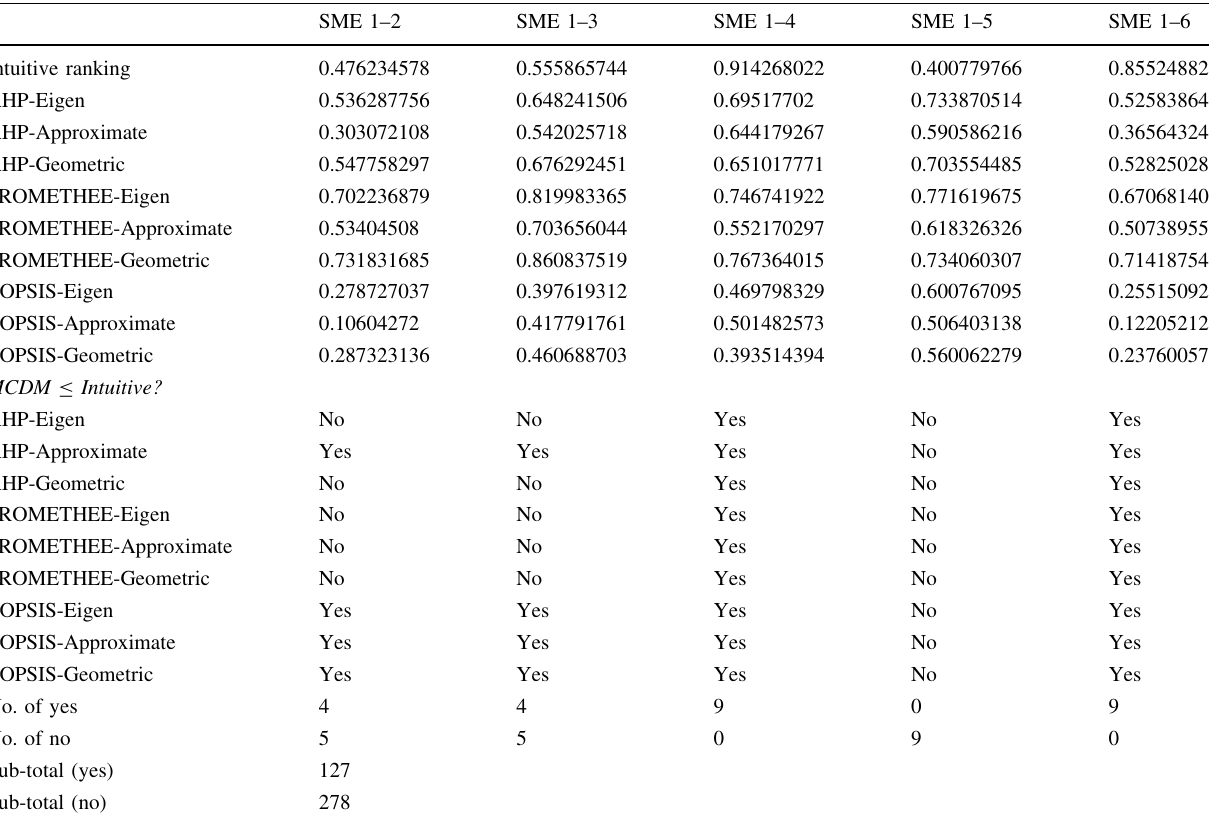
Table 18 Summary Pearson’s product–moment correlation